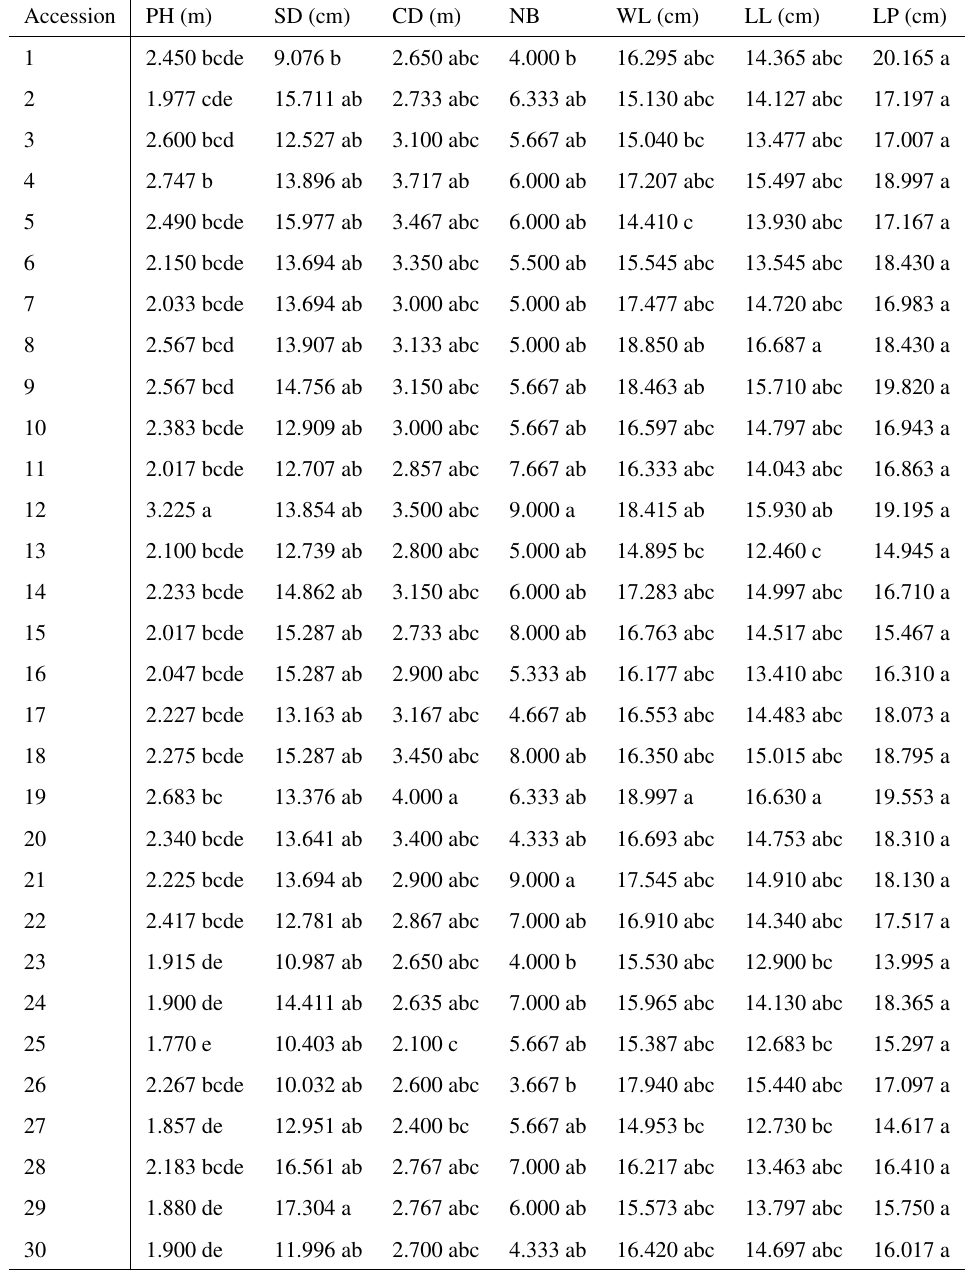
Table 3. Results of Newman Keuls'means separation test on vegetative development